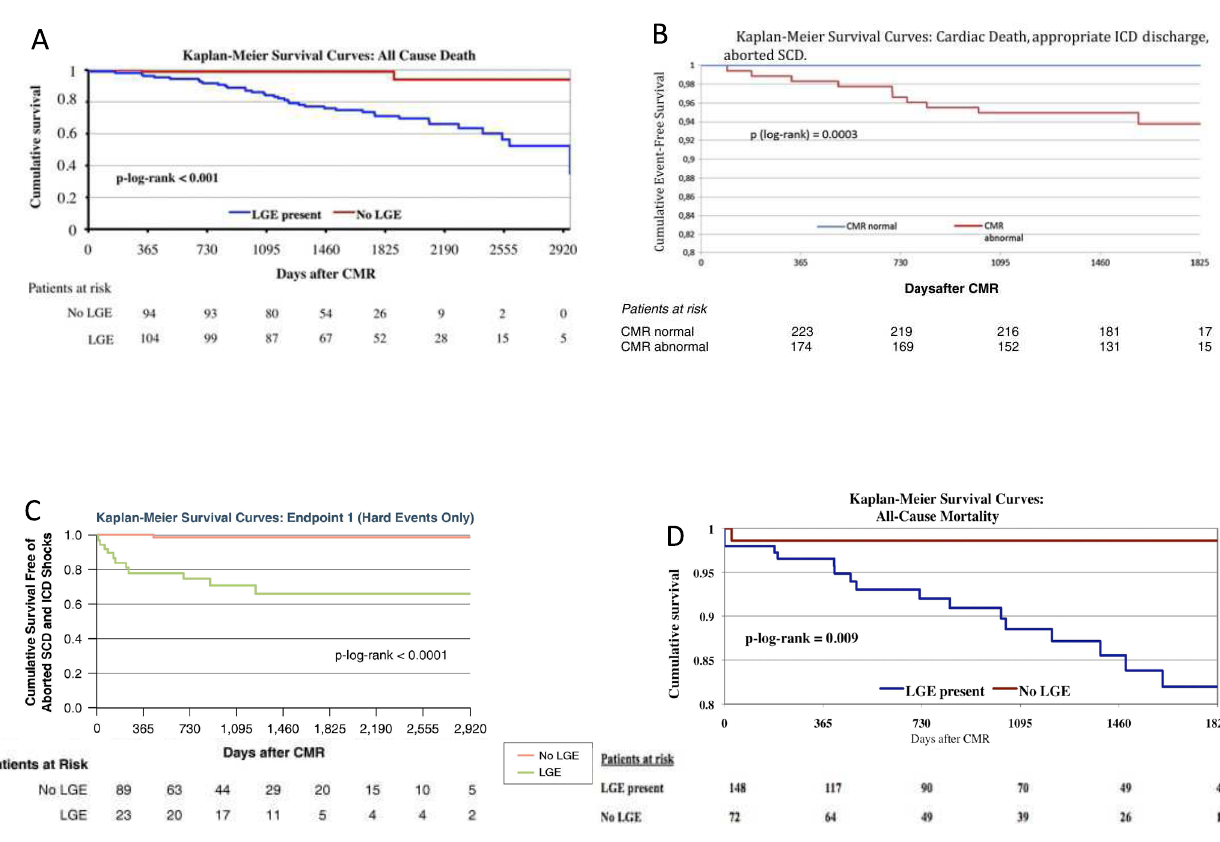
Figure 1. Kaplan Meier curves for late gadolinium enhancement (LGE)-positive and LGE-negative groups in patients with different cardiac diseases. Graphs A and B represent myocarditis, C represents sarcoidosis, and D represents hypertrophic cardiomyopathy (HCM). These graphs underline the high prognostic value of LGE–cardiac magnetic resonance (CMR). Patients who are LGE positive are at increased risk of suffering from adverse events, whereas patients who are LGE negative have an excellent prognosis. Adapted from 3–5,7 with permission . ICD, implantable cardioverter defibrillator; SCD, sudden cardiac